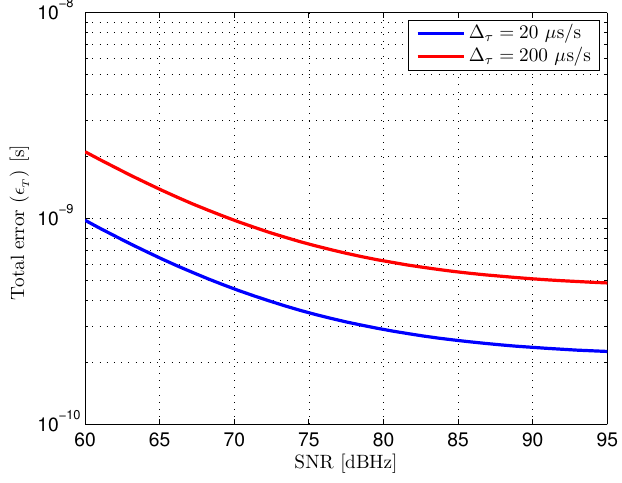
Figure 14. Expected total error ( (cid:15) change ( ∆ τ